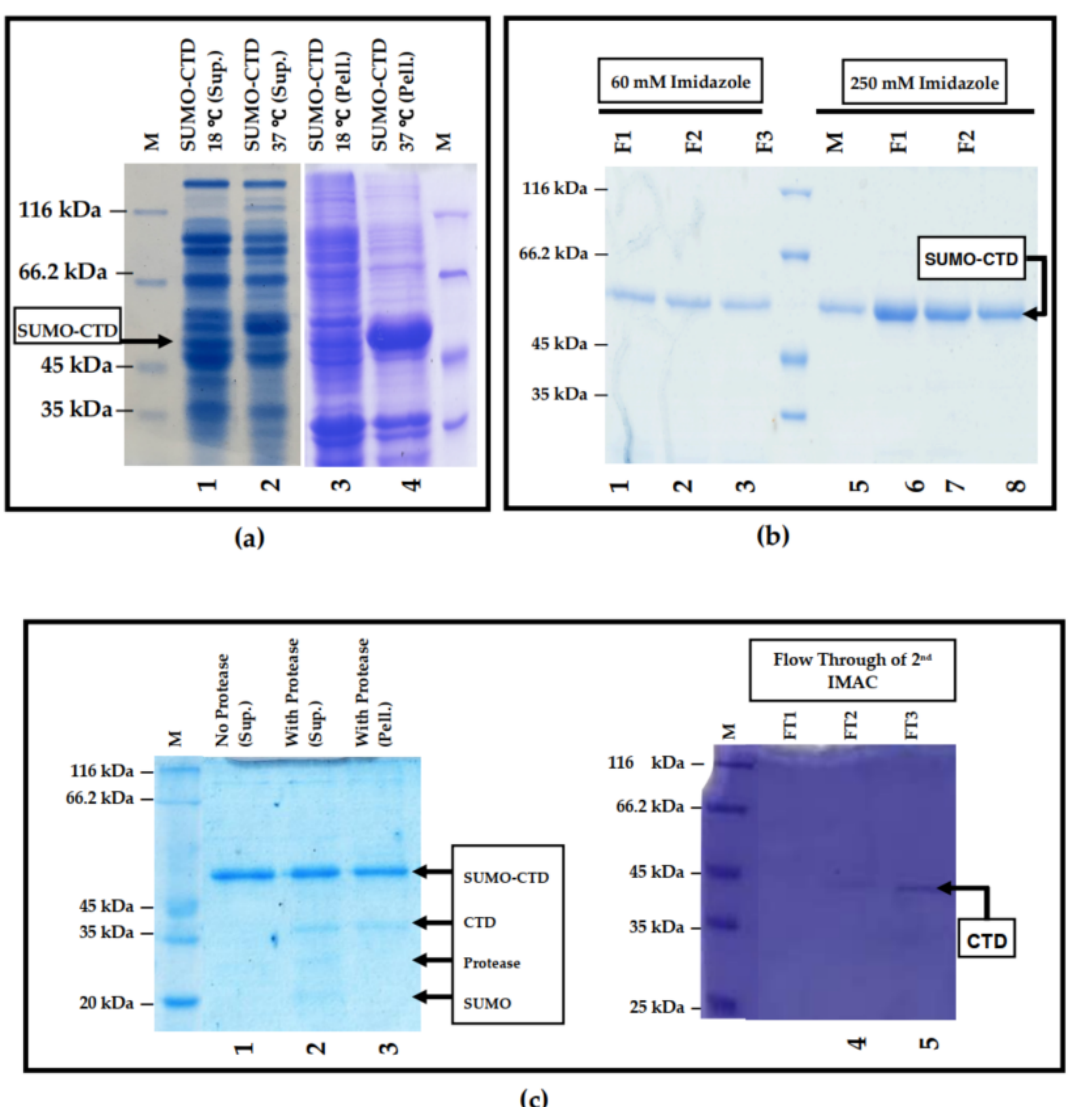
Figure 1. SUMO-muRif1-CTD expression and purification analyses. ( a ) Analyses of SUMO-muRif1- CTD expression in E. coli BL21 (DE3): Expression condition was T.B medium, 1 mM IPTG in 37 °C and 18 °C for 24 h. Samples were subjected to SDS-PAGE and stained with colloidal Coomassie Brilliant Blue. M: Marker; lane 1: Supernatant of SUMO-muRif1-CTD harboring bacterium expressed in 18 °C induced with IPTG after lysis; lane 2: Supernatant of SUMO-muRif1-CTD harboring bacterium expressed in 37 ◦ C induced with IPTG after lysis; lane 3: Pellet of SUMO-muRif1-CTD harboring bacterium expressed in 18 ◦ C with IPTG after lysis; lane 4: Pellet of SUMO-muRif1-CTD harboring bacterium expressed in 37 ◦ C with IPTG after lysis. ( b ) SDS-PAGE analysis with colloidal Coomassie Brilliant Blue staining for purification of SUMO-muRif1-CTD by nickel NTA affinity chromatography. Purification was performed with the same lysis buffer in which bacterial cell was lysed (Tris-HCl 50 mM, 300 mM NaCl, 20 mM imidazole) and eluted with different imidazole concentrations. M: Marker; lane 1–3: Elution fractions 60 mM of imidazole; lane 5–8: Elution fractions 250 mM of imidazole. The arrow indicates the position of the recombinant His-tagged SUMO-muRif1-CTD (41 kDa), which migrates at approximately 55 kDa. ( c ) Cleavage of CTD-SUMO by Lucigen SUMO Expresso ® protease. Cleavage condition was Tris-HCl pH 8, 150 mM NaCl, 1 mM DTT and 10% glycerol. M: Marker; lane 1: Cleavage reaction without protease (supernatant); lane 2: Cleavage reaction with protease (supernatant); lane 3: Cleavage reaction with protease (pellet); lane 4 and 5: Purified muRif1-CTD after